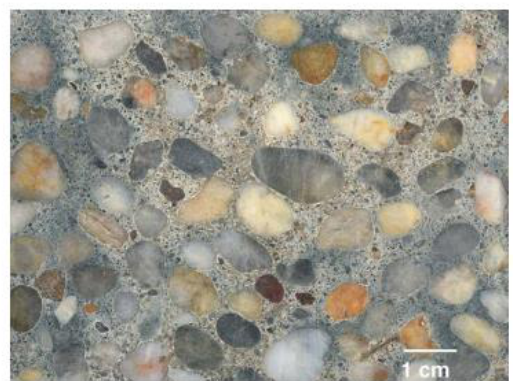
Figure 3. Cross-section of concrete with 6.35-12.7 mm natural